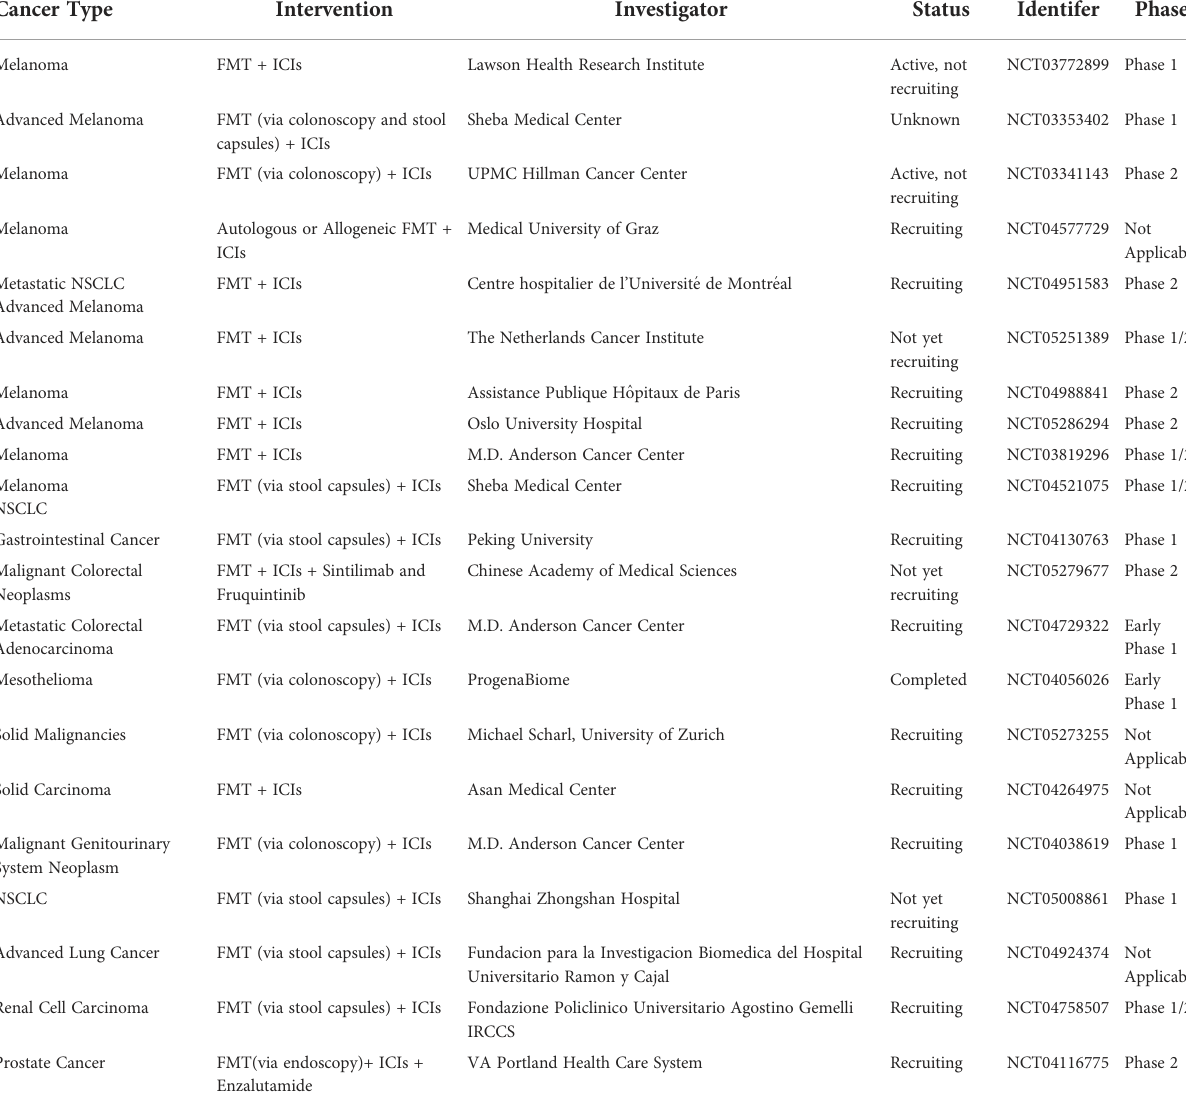
TABLE 1 Ongoing cancer clinical trials investigating FMT and